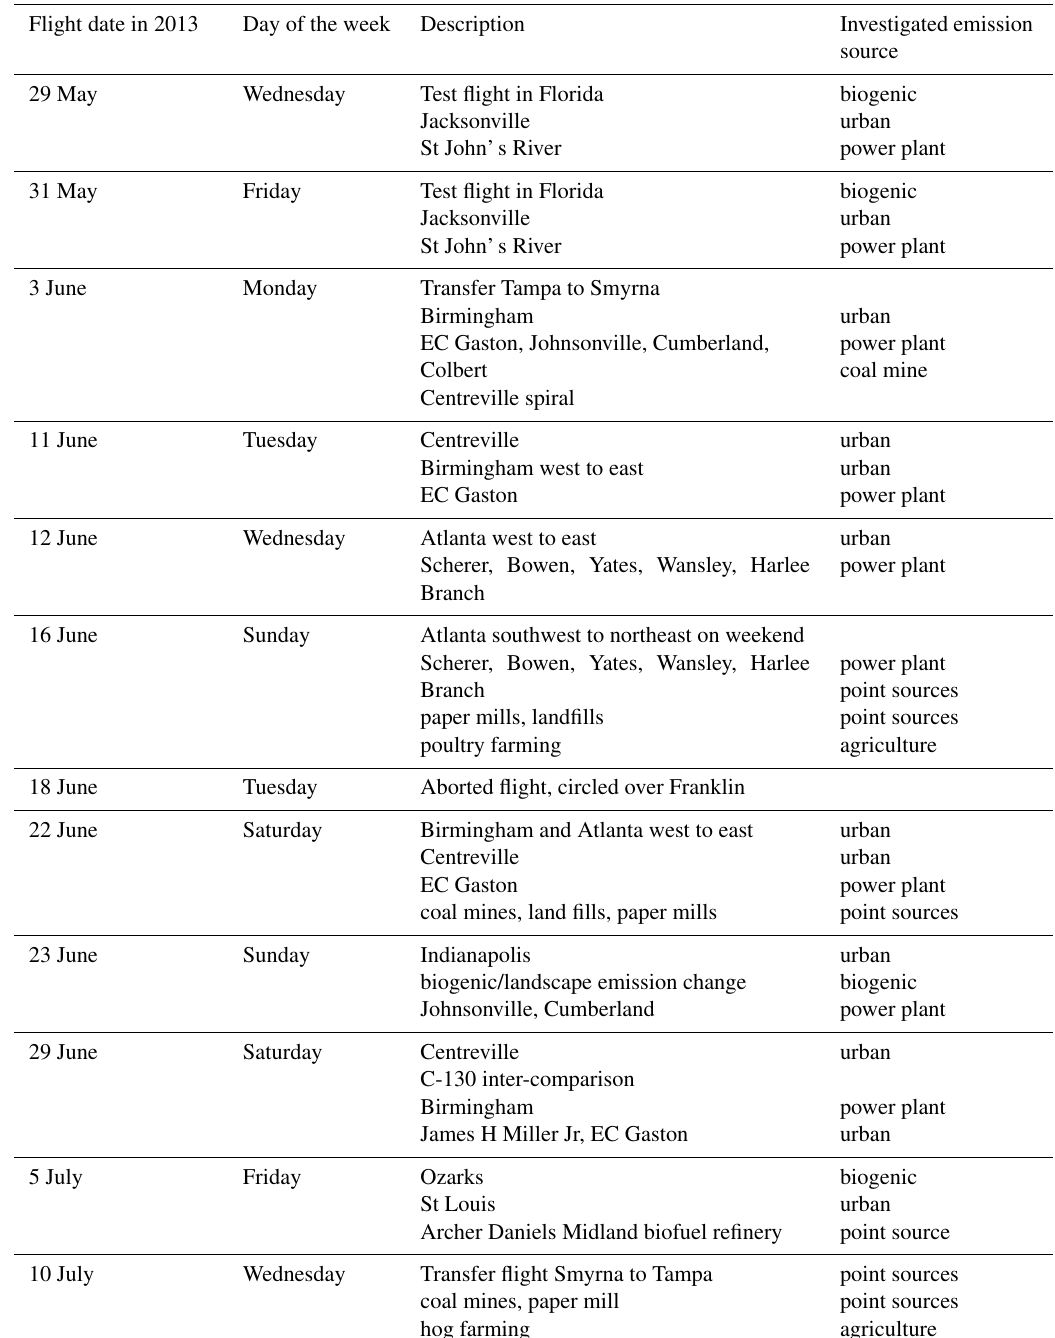
Table 2. Flight descriptions for the NOAA WP-3D daytime flights in the SE